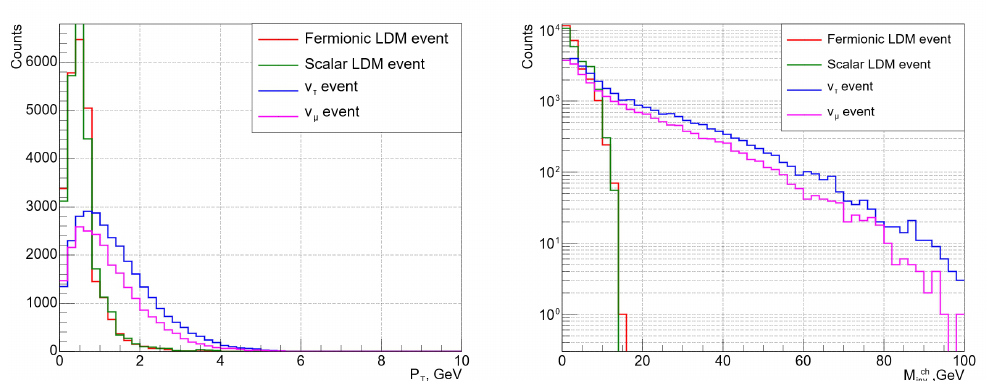
Figure 10. Distributions of the total transverse momenta and invariant mass of a system of charged secondary particles in an event for scalar and fermionic LDM, ν τ and ν µ .